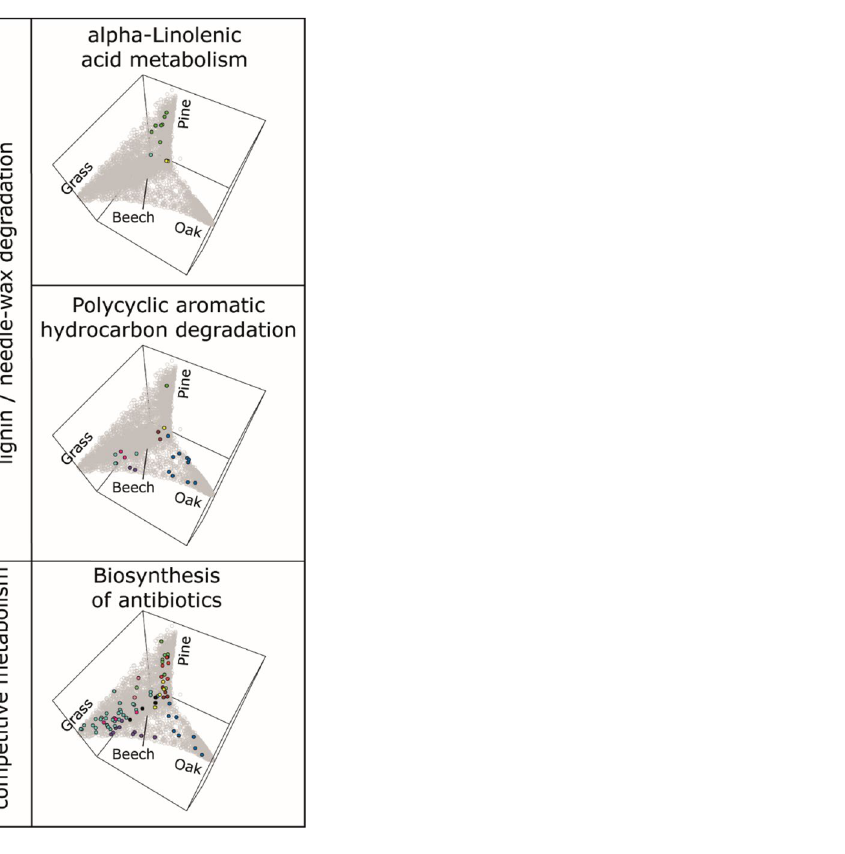
Figure 4. Molecular entities, that were annotated into metabolic pathways, are highlighted within the same weighted correlation network of DOM. Pathways, that are indicative of the degradation of needle waxes (top) and lignin (middle) are highly and little expressed in the pine litter, respectively, suggesting specifically optimized degradation strategies. Molecules in the pathway ‘biosynthesis of antibiotics‘ (bottom) are ubiquitously